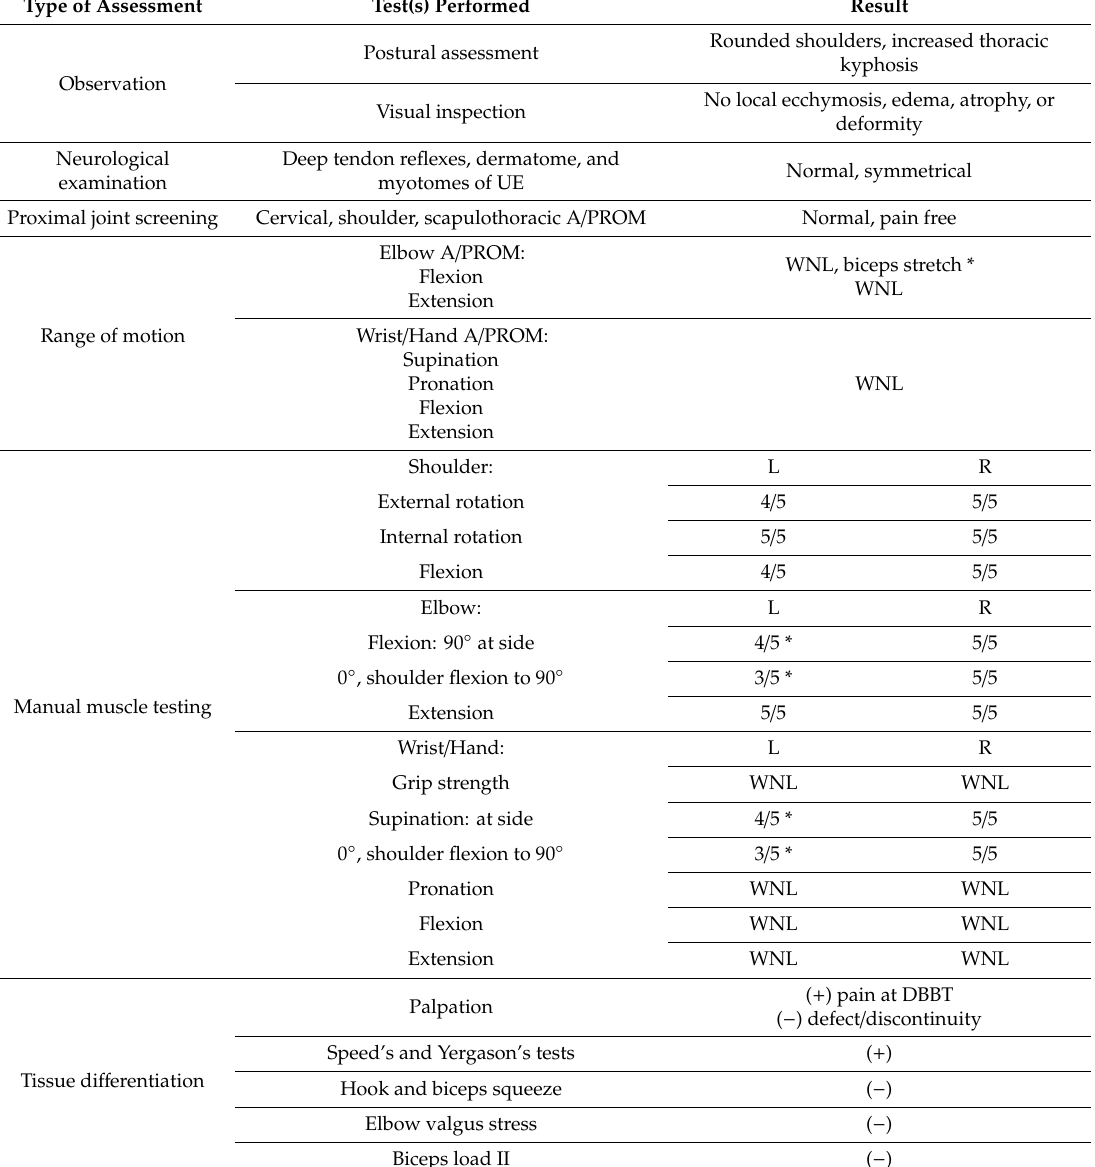
Table 1. Examination